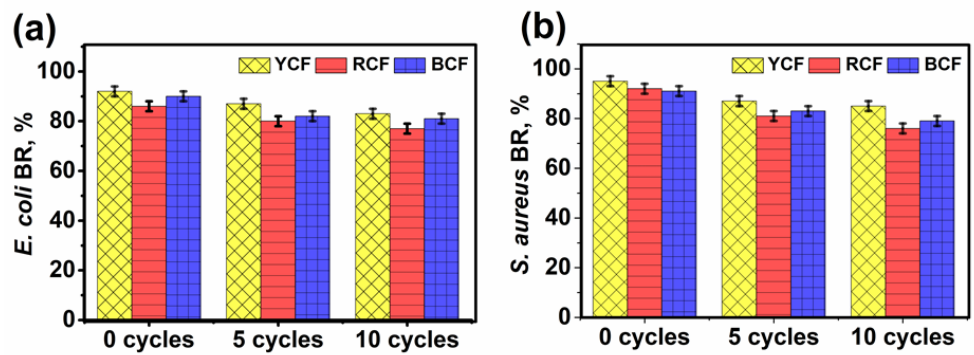
Figure 9. Bacterial reduction (%) of YCF, RCF, and BCF before (0 cycles) and after 5 and 10 washing cycles against bacteria: ( a ) E. coli ; and ( b ) S. aureus .